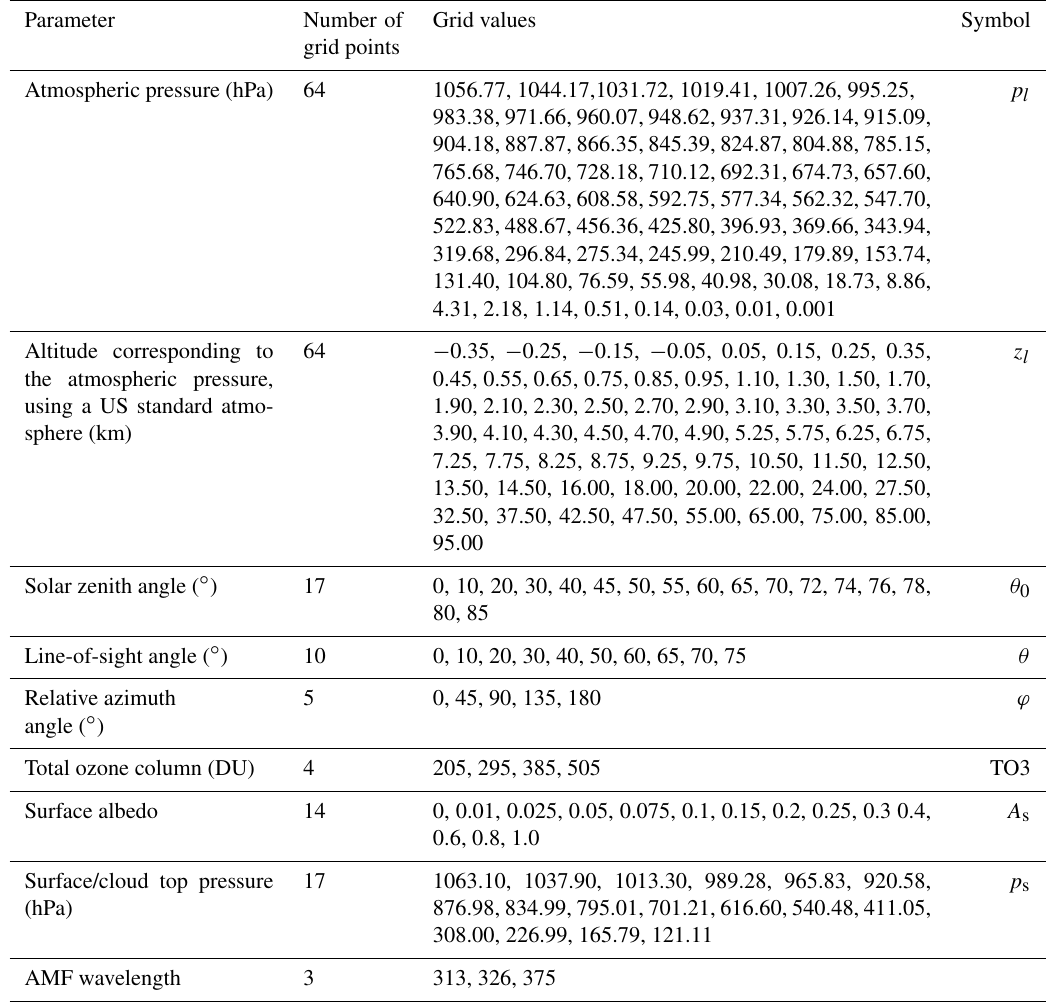
Table 4. Physical parameters that define the WF look-up table.